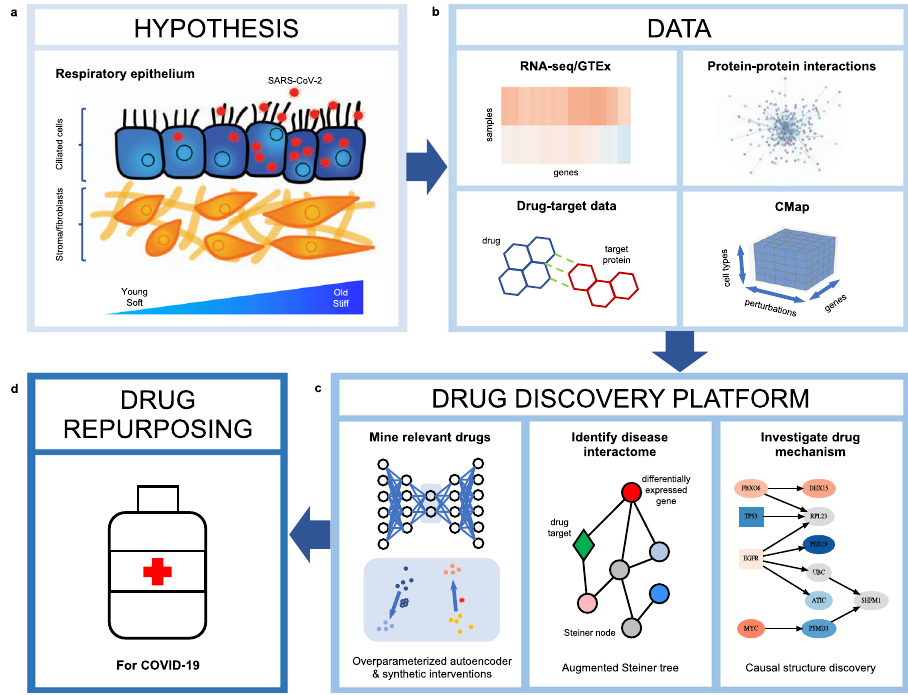
Fig. 1 Overview of computational drug repurposing platform for COVID-19. a COVID-19 is associated with more severe outcomes in older individuals, suggesting that gene expression programs associated with SARS-CoV-2 and aging must be analyzed in tandem. A potential hypothesis regarding the cross-talk between SARS-CoV-2 and aging relies on changes in tissue stiffness in older individuals, outlined in ref. 21 . Ciliated cells are denoted in blue, stromal/ fi broblast cells are in orange and SARS-CoV-2 viral particles are in red. b In order to identify potential drug candidates for COVID-19, we integrated RNA-seq data from SARS-CoV-2-infected cells, obtained from ref. 23 , and RNA-seq data from the lung tissue of young and old individuals, collected as part of the Genotype-Tissue Expression (GTEx) project 24 , with protein – protein interaction data (from ref. 42 ), drug – target data (from DrugCentral 45 ) and the large-scale transcriptional drug screen Connectivity Map (CMap) 2 . c , d Based on this data, we develop a drug repurposing pipeline, which consists of fi rst, mining relevant drugs by matching their signatures with the reverse disease signature in the latent embedding obtained by an overparameterized autoencoder and sharing data across cell types to obtain missing drug signatures via synthetic interventions. Blue and orange points in the latent space represent data associated with the drug screen and the SARS-CoV-2 infection study. Second, we identify a disease interactome within the protein – protein interaction network by identifying a minimal subnetwork that connects the genes differentially expressed by SARS-CoV-2 infection and aging using a Steiner tree analysis. Third, we validate the drugs identi fi ed in the fi rst step that have targets in the interactome (greed diamond) by identifying the potential drug mechanism using causal structure discovery. Nodes are colored according to the log 2 -fold gene expression change associated with SARS-CoV-2 infection, and gray nodes indicate Steiner